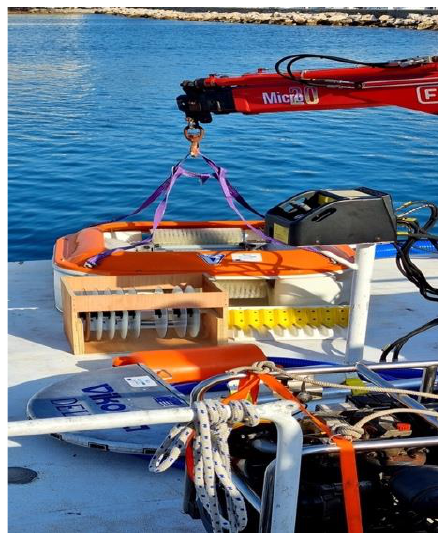
Figure 7 . Testing efficiency of brush and disc skimmer [Authors]. Figure 7. Testing efficiency of brush and disc skimmer